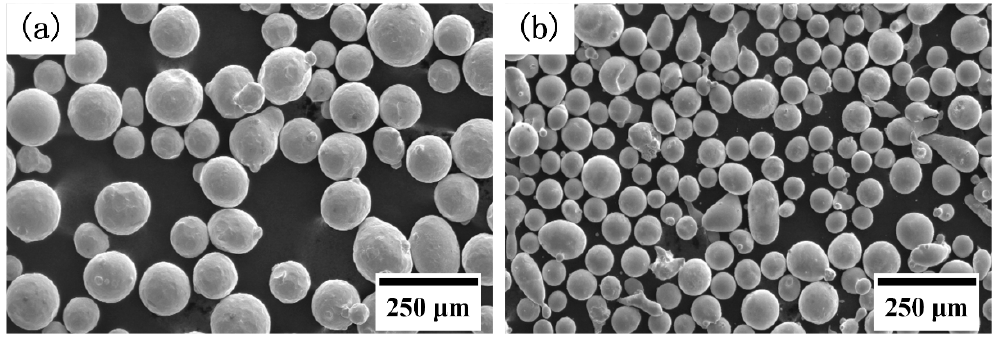
Figure 1. SEM micrographs of ( a ) 410L powder and ( b ) Fe–Cr–B–Si–Mo powder. Table 1. Chemical composition of 410L, Fe–Cr–B–Si–Mo , and AISI 5140 and AISI 1060 steel alloys (wt%).